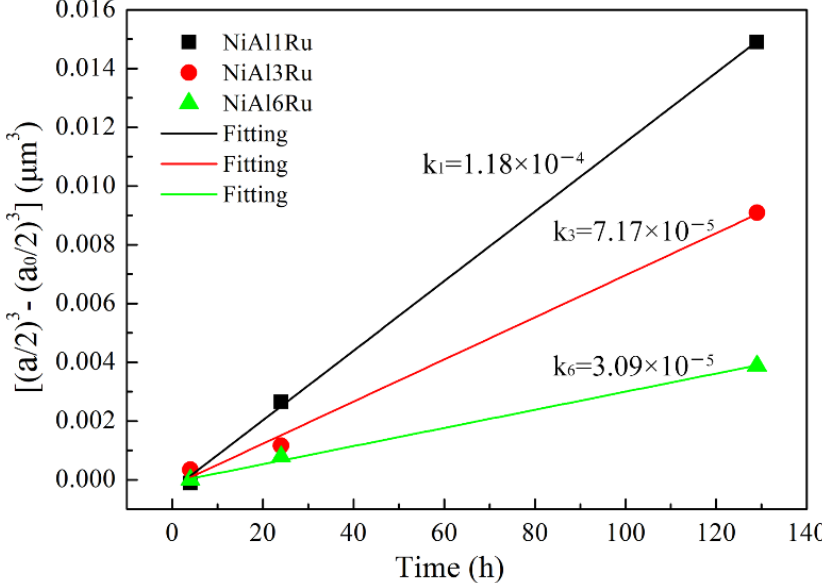
Figure 2. Relationship between mean size of γ′ precipitates and aging time.